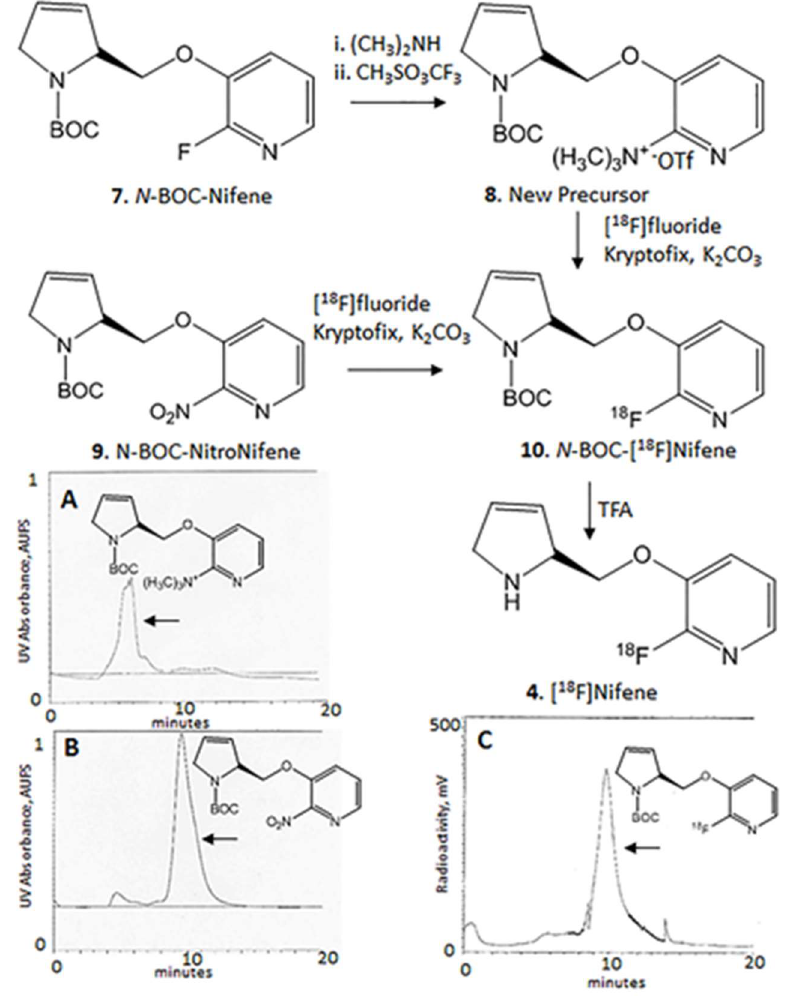
Figure 2. Improved [ 18 F]nifene (4) synthesis. N -BOC-nifene (7) was converted to the